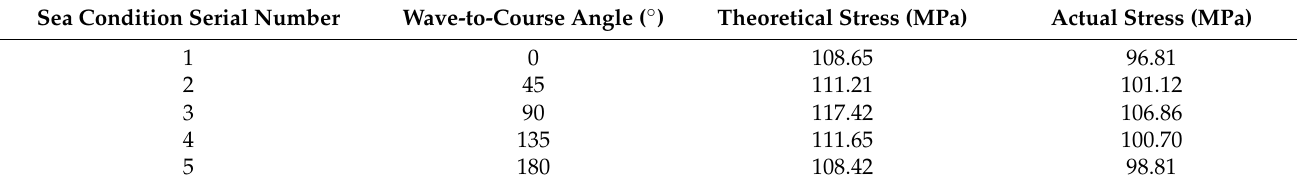
Table 11. Maximum stress of lower support component under tensioner during piping-laying (measuring point